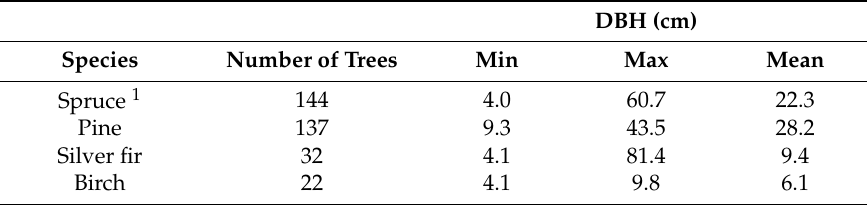
Table 1. Summary of trees with species and diameter at breast height (DBH).